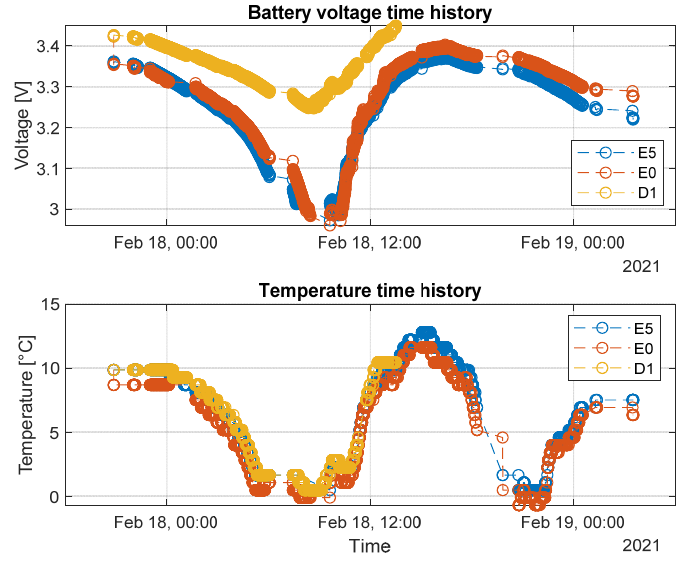
Figure 16. Example of battery voltage and temperature data.